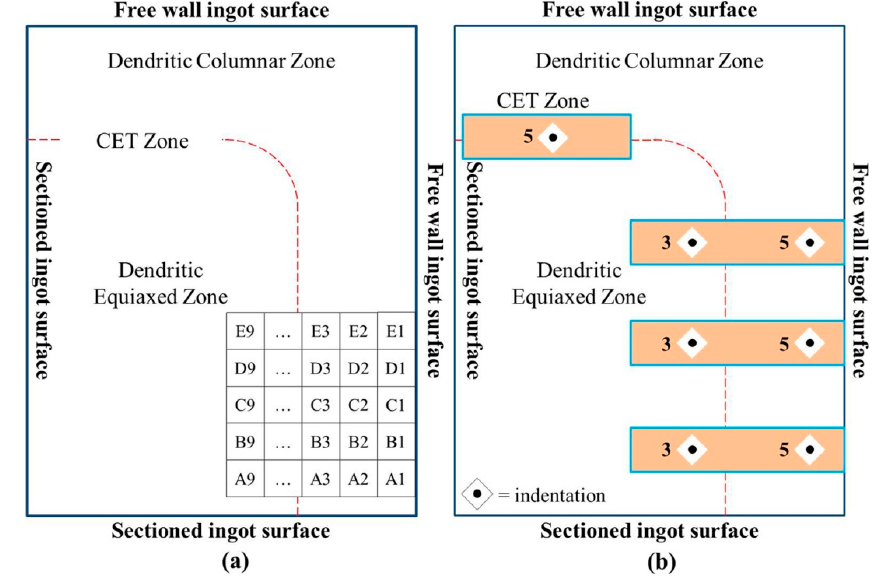
Figure 1. A quarter of TWIP steel ingot sample: ( a ) image arrangement procedure for tracking solidification zones and microstructure and ( b ) microhardness testing methodology.